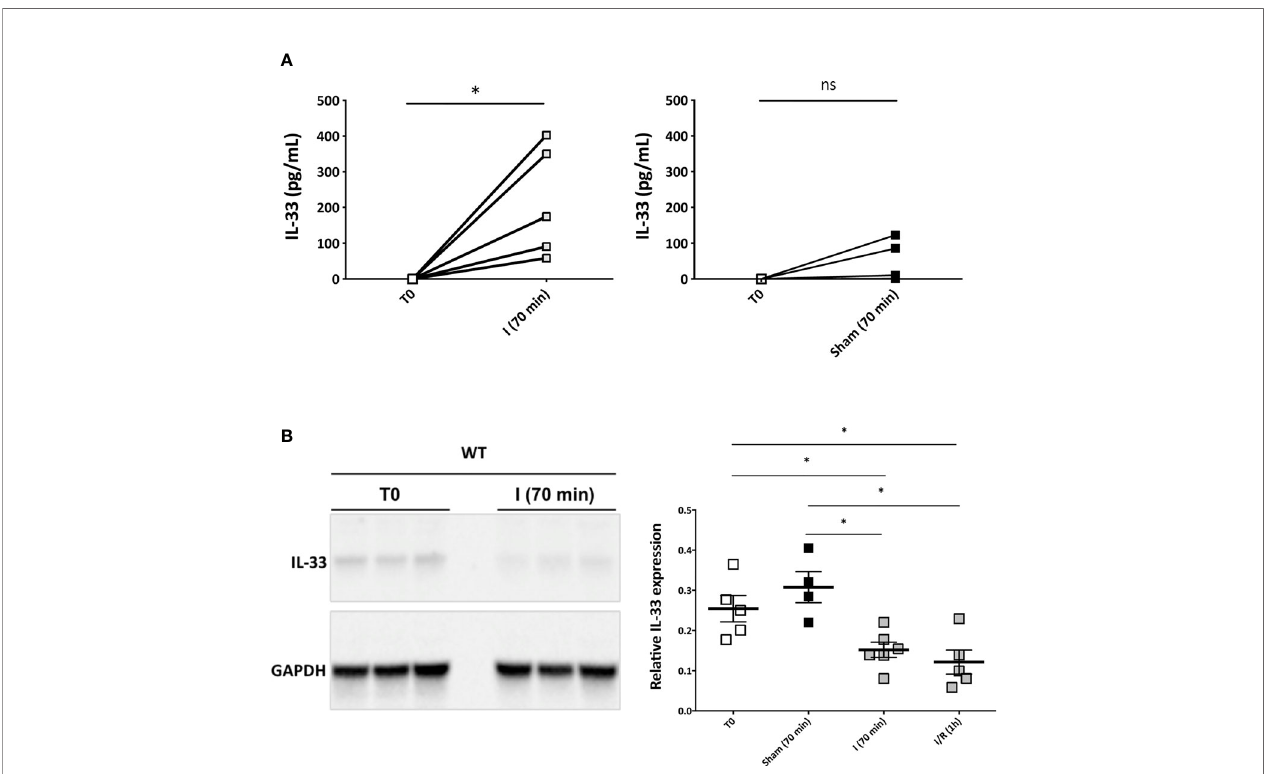
FIGURE 1 | Endogenous IL-33 is immediately released in systemic circulation in response to hepatic pedicle clamping and reaches peak levels at the end of the ischemic phase (mouse model). (A , left) Plasma levels of IL-33 in picograms per milliliter measured by ELISA method in the same animals before any surgical procedure (T0) and at the end of the ischemia phase [I (70 min)]. Each value is displayed, Wilcoxon signed-rank test, n = 5 animals. (A , right) Plasma levels of IL-33 in picograms per milliliter in WT mice measured by ELISA method in the same animals before any surgical procedure (T0) and after Sham surgical procedure. Wilcoxon signed-rank test, n = 5 animals. For each time point tested, plasmas of IL-33 – de fi cient mice displayed undetectable levels. (B) Total IL-33 content of the liver by Western blotting in WT mice before any surgical procedure (T0), at the end of the ischemia phase (I (70 min)) and after 1 h of reperfusion (I/R) (1 h), and in Sham animals. Expression of IL-33 was normalized against GAPDH expression. Mean ± SEM, two-tailed Mann-Whitney U test, n = 4 – 6 mice per group. ns, not signi fi cant; * p <